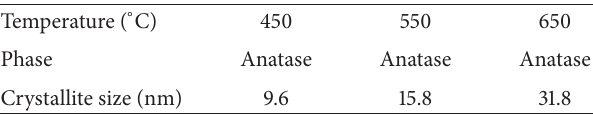
Table 3: Phase analysis results of the polymeric titania membrane at different calcination